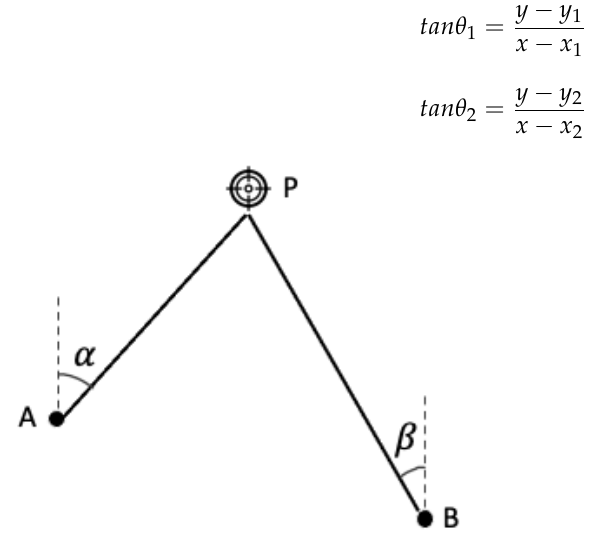
Figure 5. AOA—based distance